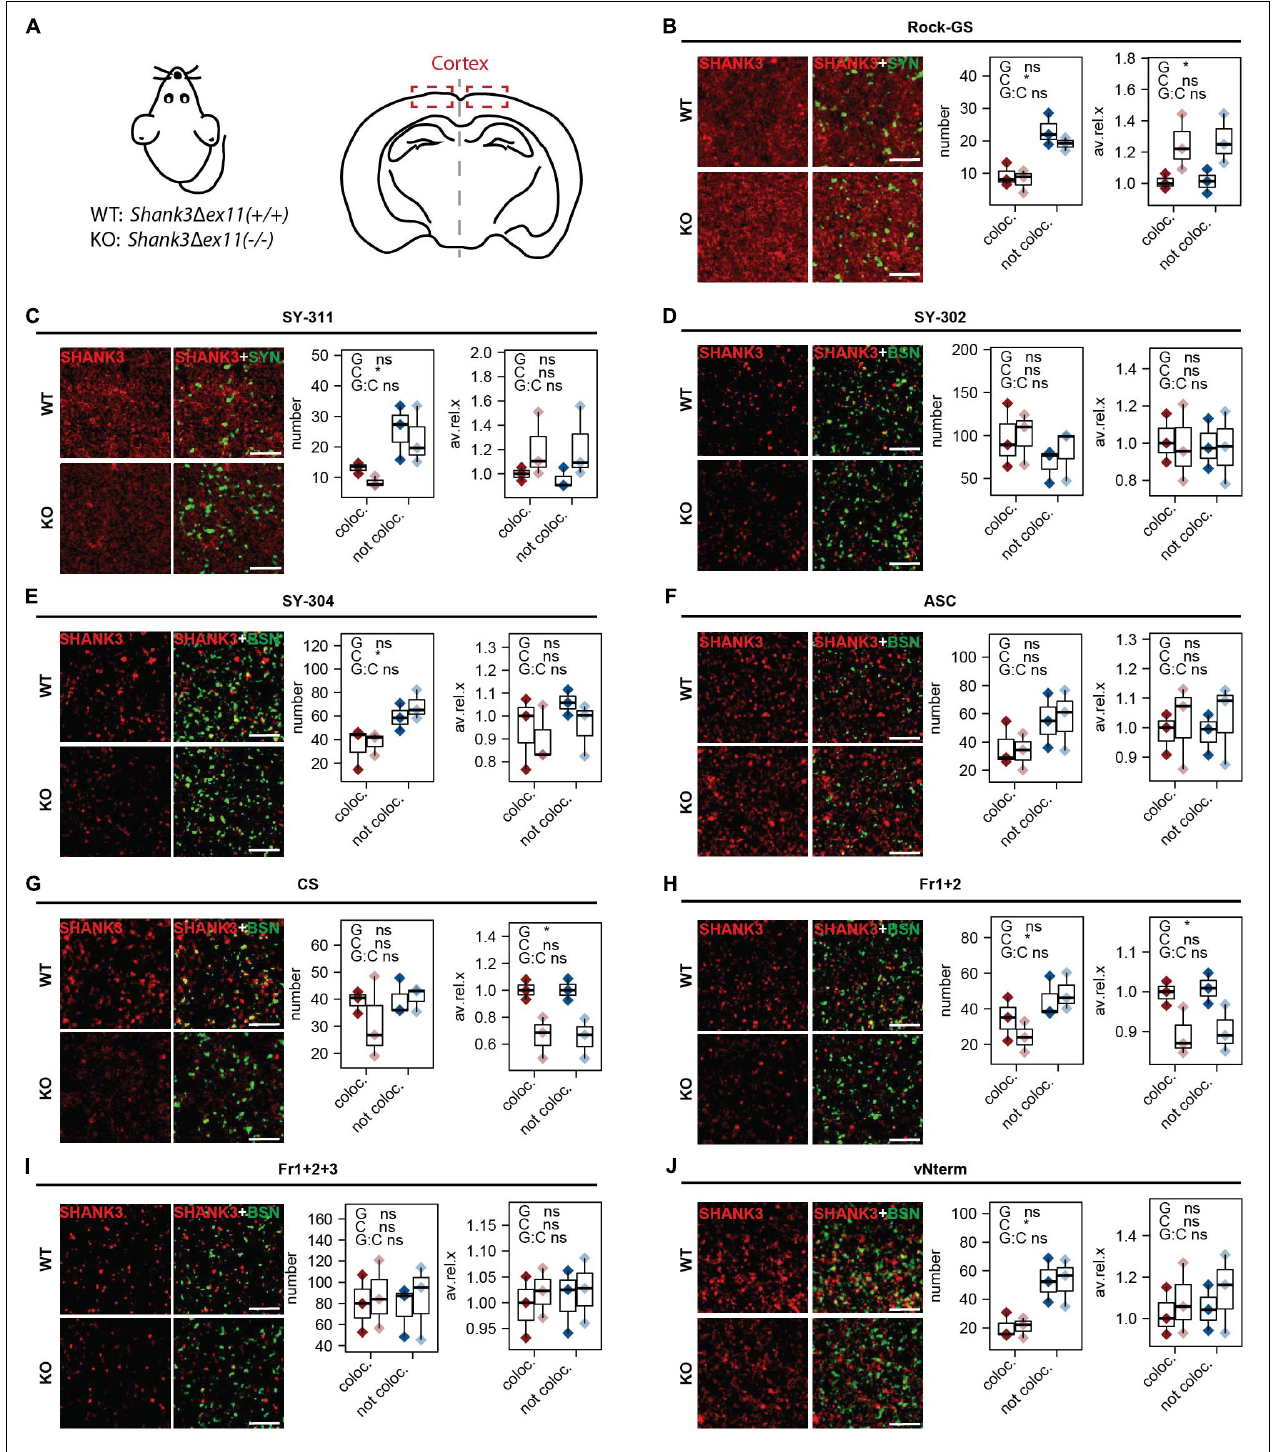
FIGURE 6 | IHC analysis in cortex of mouse brain sections. (A) Sections of WT [ Shank3( + / + ) ] and KO [ Shank3 (cid:49) ex11(–/–) ] mice were analyzed. Sections were stained against SYNAPSIN1/2 or BASSOON and (B) Rock-GS, (C) SY-311, (D) SY-302, (E) SY-304, (F) ASC, (G) CS, (H) Fr1+2, (I) Fr1+2+3, and (J) vNterm. Scale bar 5 µ m. ICC of WT and KO are shown. Left graph: Number of synapses. SHANK3 puncta co-localizing with the respective pre-synaptic marker (red) or not co-localizing (blue) are shown. Right graph: Average intensity of SHANK3 puncta. The boxplot shows the median and the interquartile range, the whiskers cover minimal to maximal values. n = 3 animals per genotype. One-way ANOVA. G: genotype. C: co-localization or not. G:C: correlation of genotype and co-localization. * p ≤ 0.05.